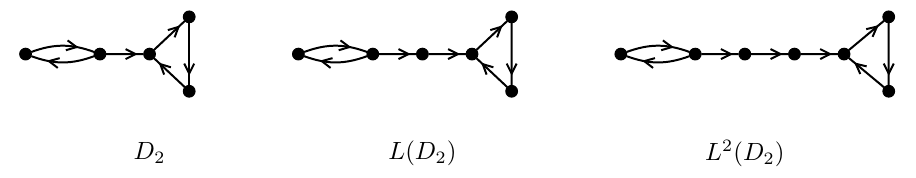
Figure 12: An example of line iterates of a digraph with a pair of joined cycles.